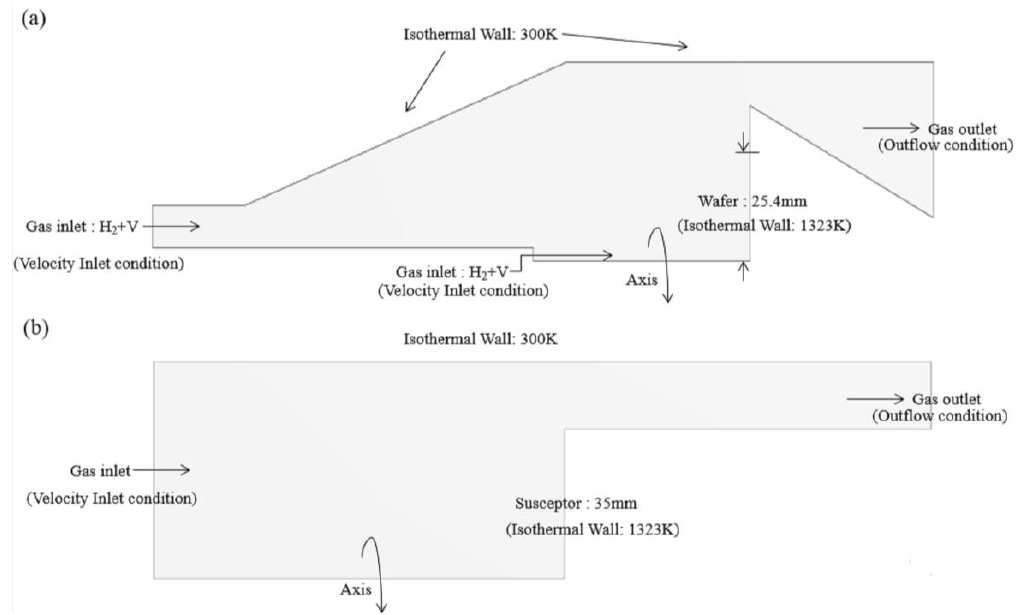
Figure 11. Schematic diagram of ( a ) Experiment 1 [10] and ( b ) Experiment 2 [11].